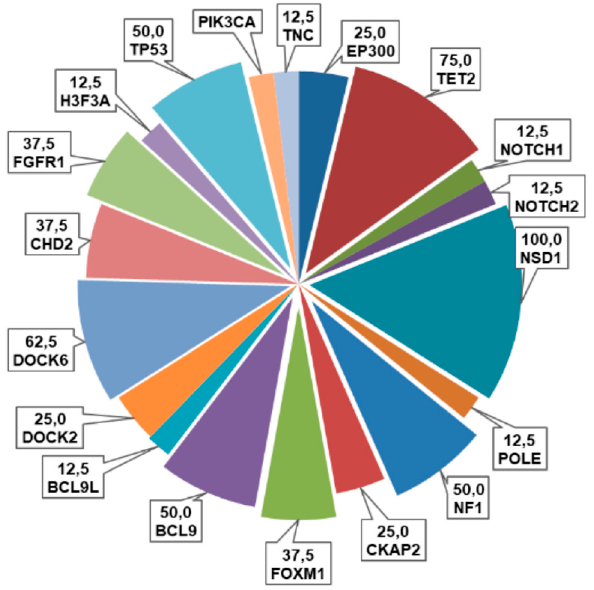
Figure 3. Pie chart representing the frequencies (%) of alterations of the examined genes in this cohort of pHGGs.